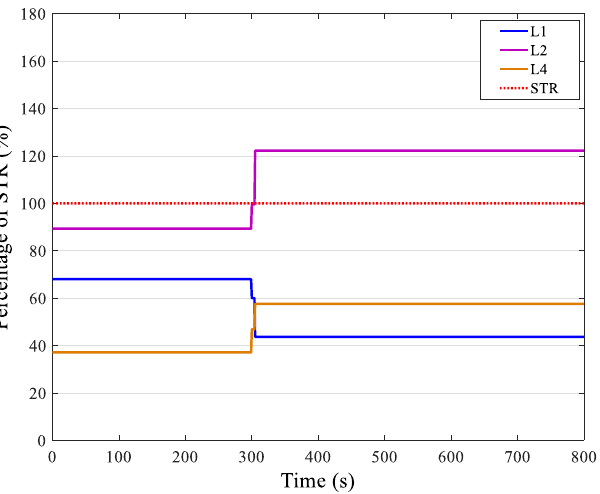
Figure 7. Current variation of fault 1.